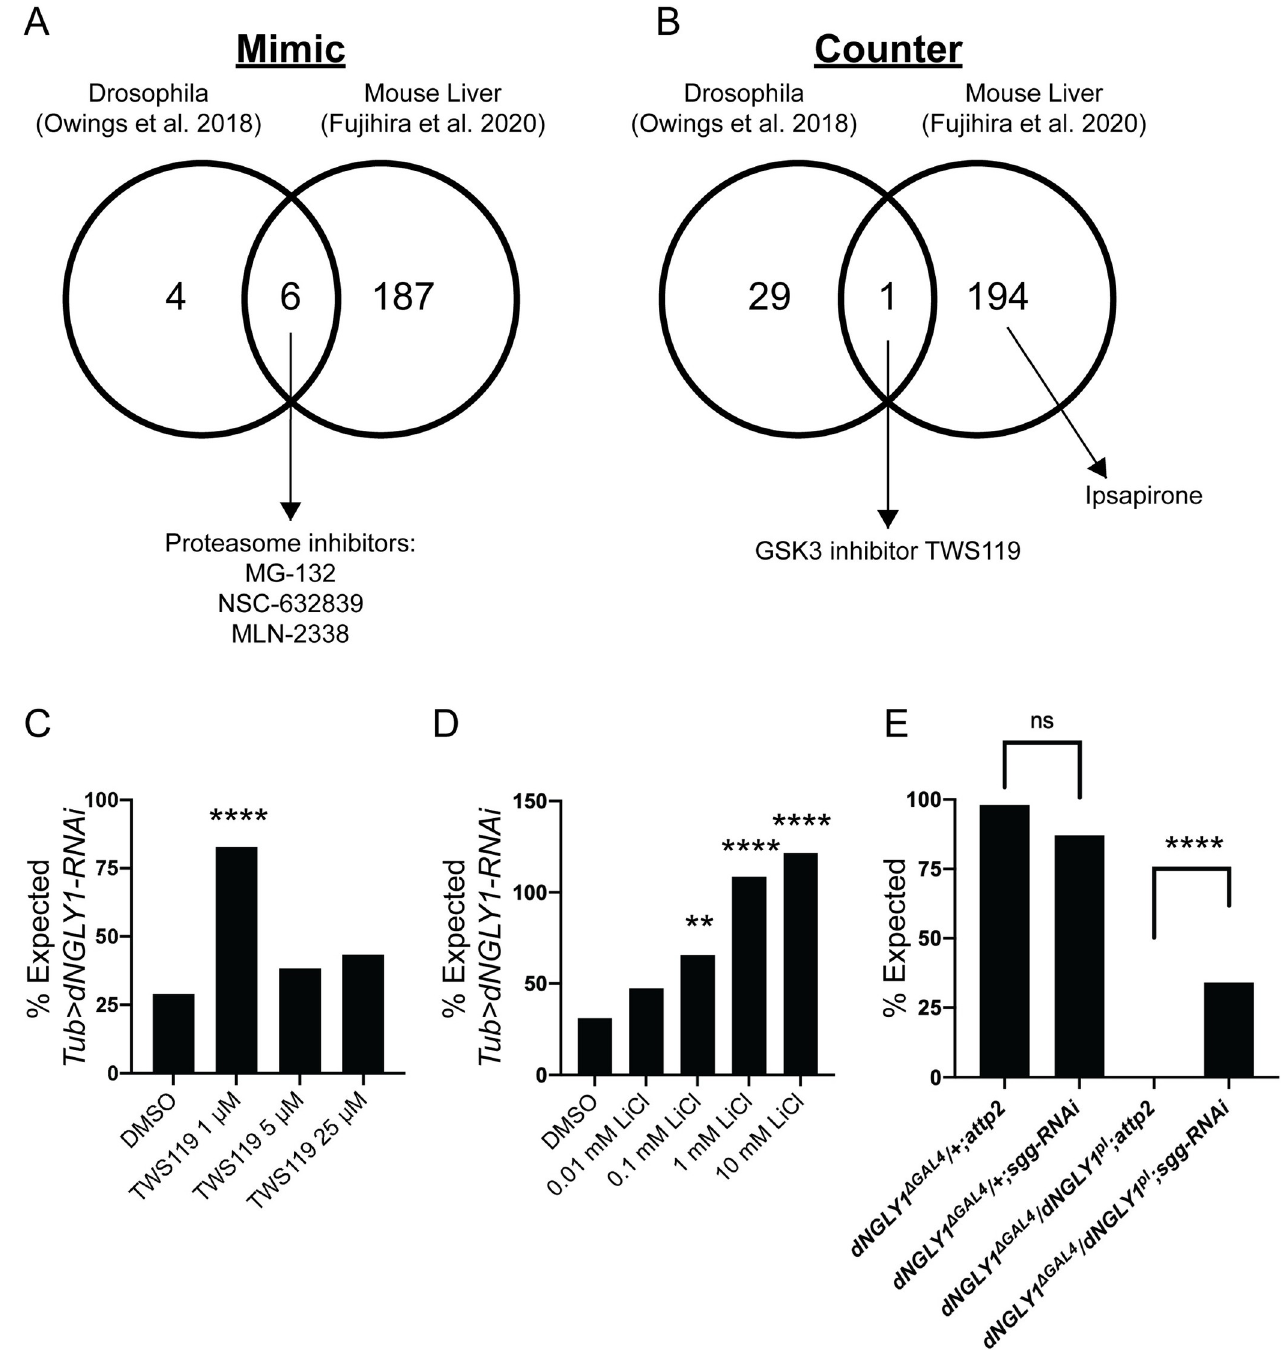
Fig 5. CMAP analyses identifies GSK3 inhibition as a therapeutic mechanism. A) Ten compounds were predicted to mimic the transcriptional response due to dNGLY1 knockdown in flies [12]. In the mouse liver data set, 193 compounds were predicted to mimic the transcriptional response due to the loss of Ngly1 [29]. The fly and mouse data sets shared six compounds, three of which are proteasome inhibitors. B) In the fly dataset, 30 compounds were predicted to counter the transcriptional response due to dNGLY1 knockdown. In the mouse liver dataset, 195 compounds were predicted to counter the transcriptional response due to loss of Ngly1 . The GSK3 inhibitor TWS119 was the only compound shared between the two data sets. C) TWS119 rescued the lethality of Tubulin > dNGLY1-RNAi flies at 1 μ M but did not rescue lethality at 5 or 25 μ M. D) Lithium chloride (LiCl) showed a dose response effect and significantly rescued lethality in Tubulin > dNGLY1-RNAi flies at 0.1 mM, 1 mM, and 10 mM. The lowest dose at 0.01 mM did not increase survival of Tubulin > dNGLY1-RNAi flies. E) Sgg-RNAi did not impact lethality in heterozygous dNGLY1 Δ GAL4/+ flies. However, sgg-RNAi rescued lethality in dNGLY1 Δ GAL4/pl flies that lack functional dNGLY1 . ���� p < 0.0001, �� p <